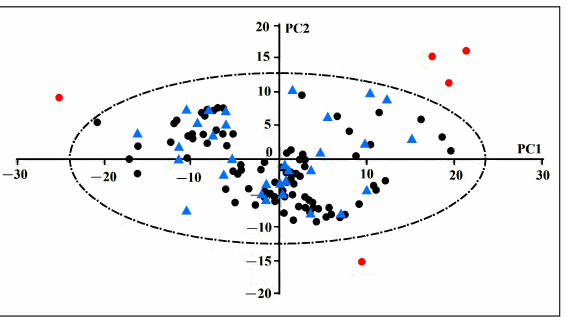
Figure 3. 2D score plot of the first two PCs provided by Principal Component Analysis (PCA) applied on the spectra (calibration set, validation set and outliers are shown as black circles, blue triangles and red circles,